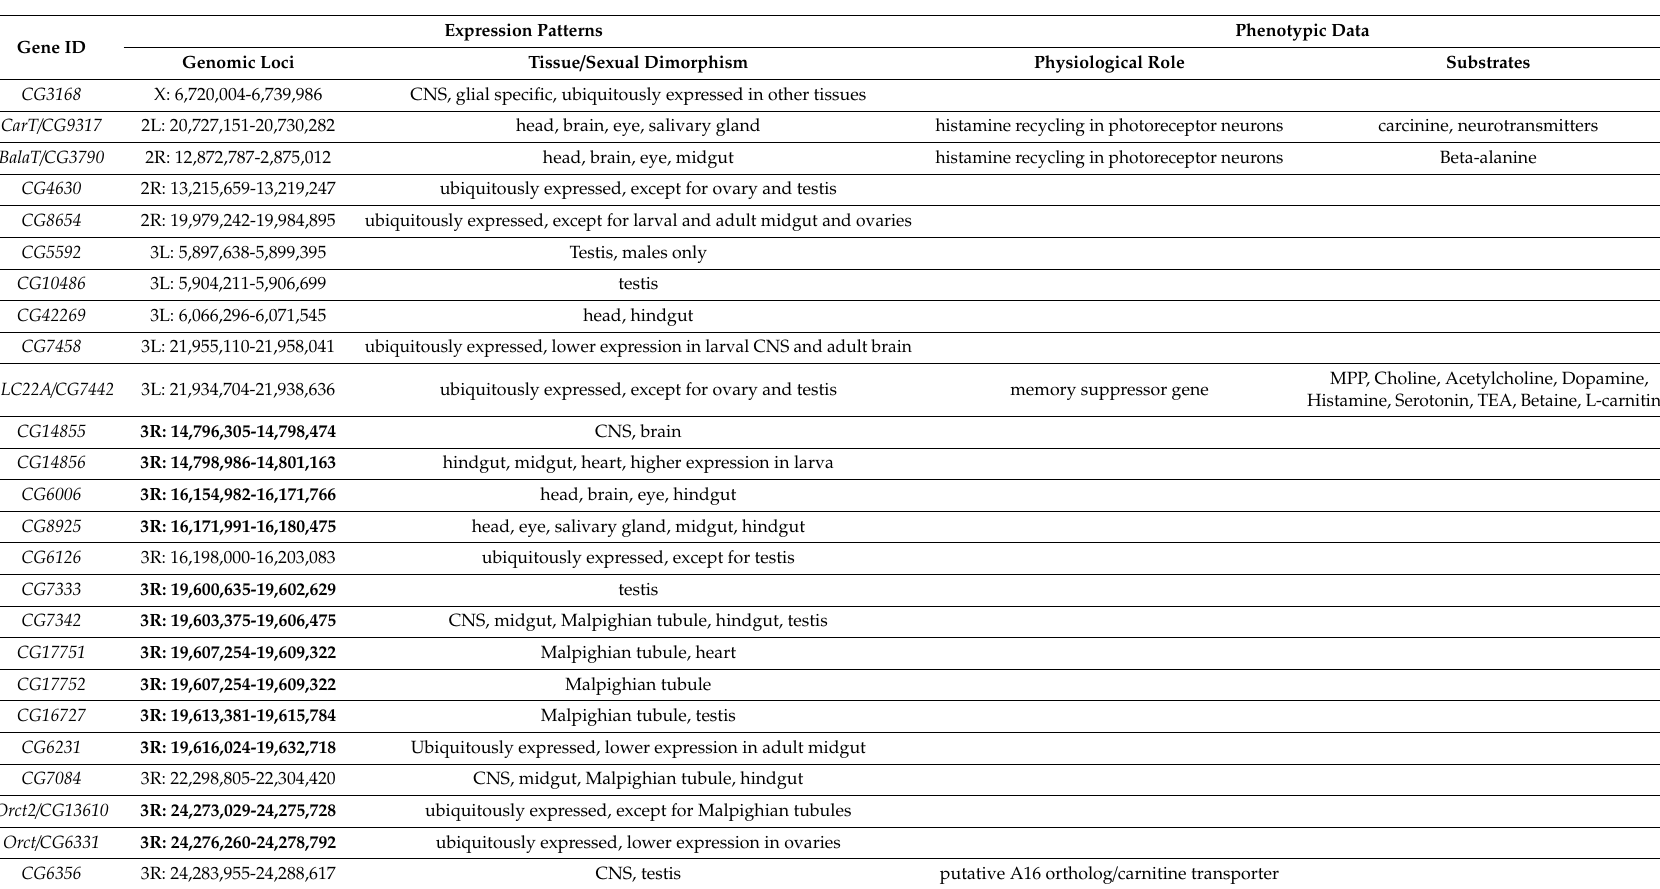
Table 1. Overview of SLC22 in Drosophila melanogaster . The following table describes all known and putative orthologs of SLC22 in D. melanogaster . Genes are ordered by chromosomal location and those which appear in tandem are bolded. Tissue expression was collected from FlyAtlas